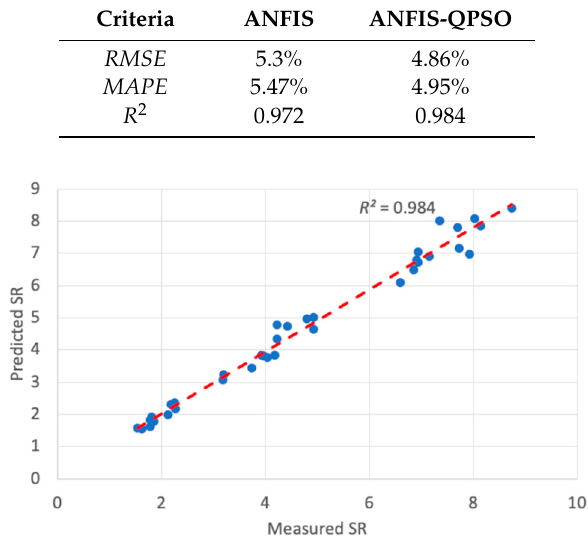
Figure 7. Experimental surface roughness vs. predicted surface roughness values of a dry turning process using ANFIS-QPSO. Table 7. ANFIS vs. ANFIS-QPSO performance comparison for the dry turning process.